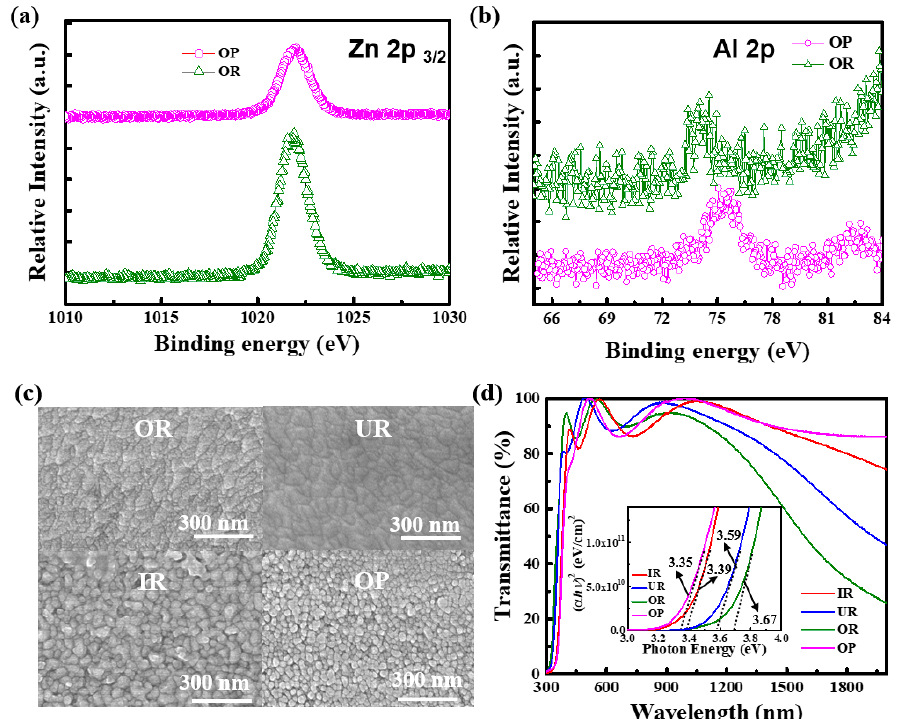
Figure 3. SLG substrates at different locations relative to target material, with deposited AZO film characteristics as follows: ( a ) XPS spectra of Zn 2p 3/2 at locations OP and OR; ( b ) Al 2p binding energy measurements; ( c ) SEM measurements; ( d ) optical transmittance.